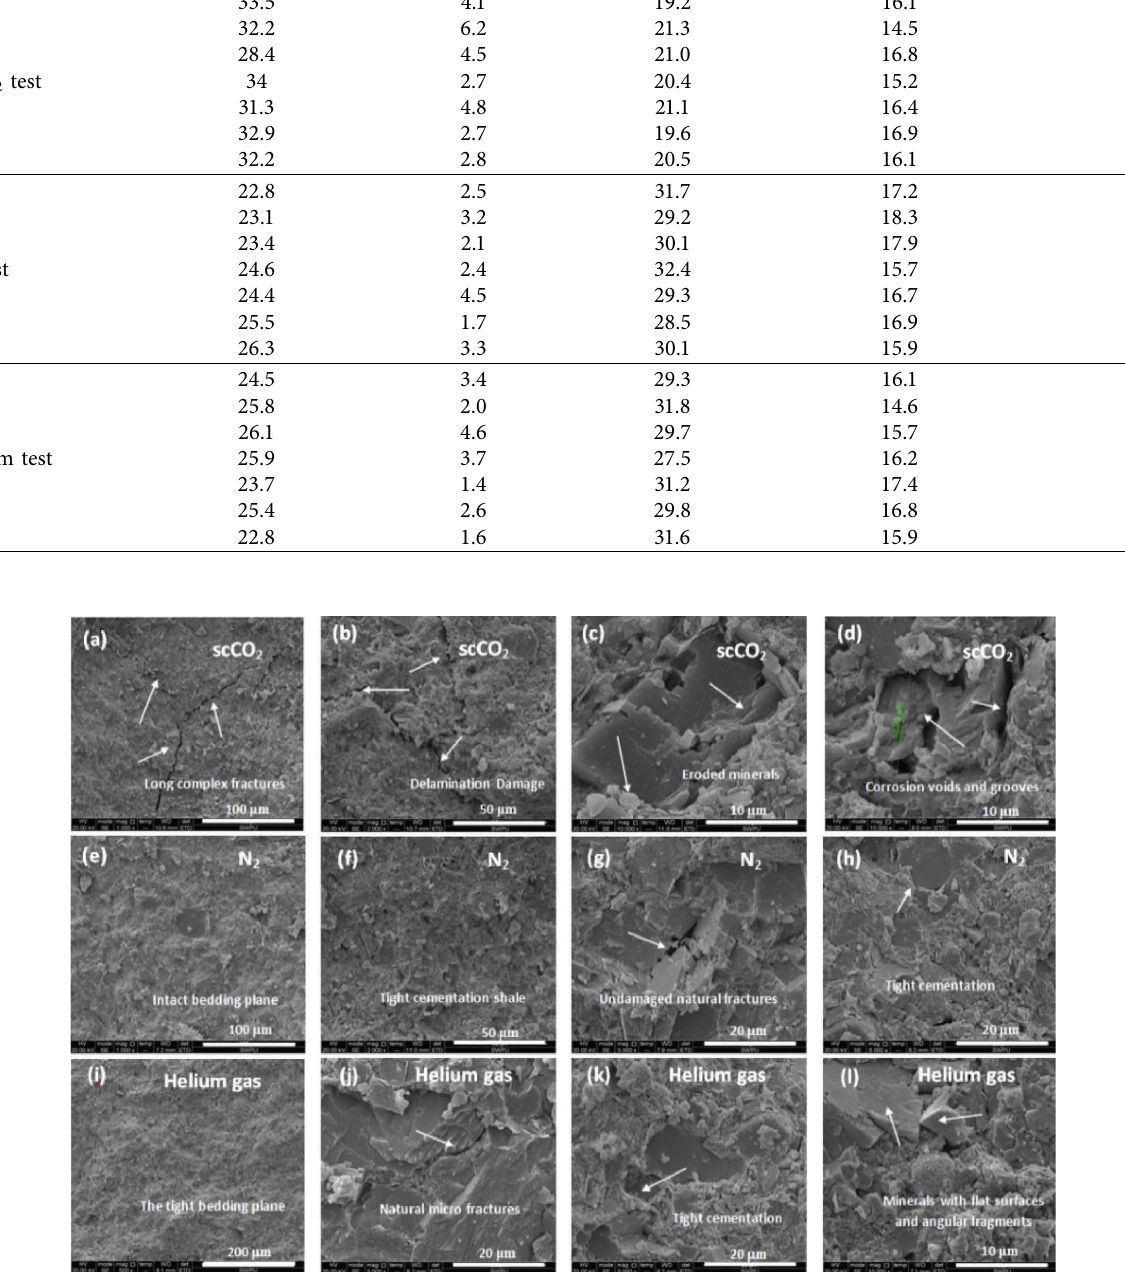
Figure 16: Microscopic structures picture of diferent experimental